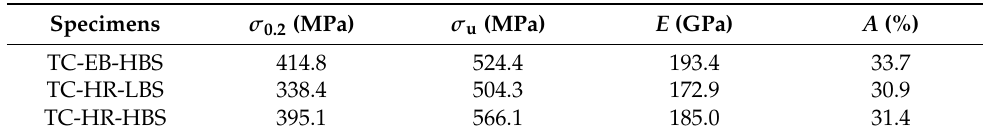
Table 2. Average values of the measured mechanical